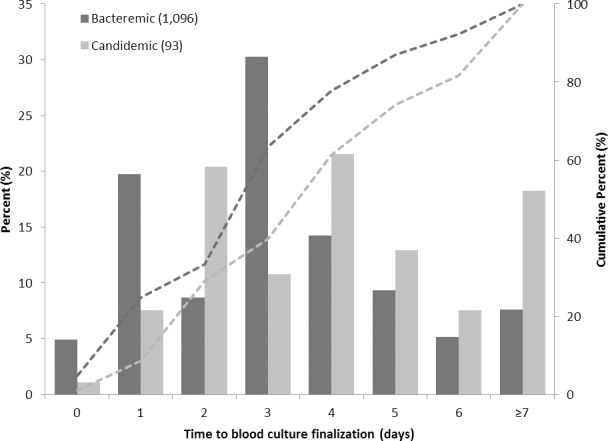
Time to receipt of final blood culture results (in days) for critically ill patients with bacteremia compared to candidemia.